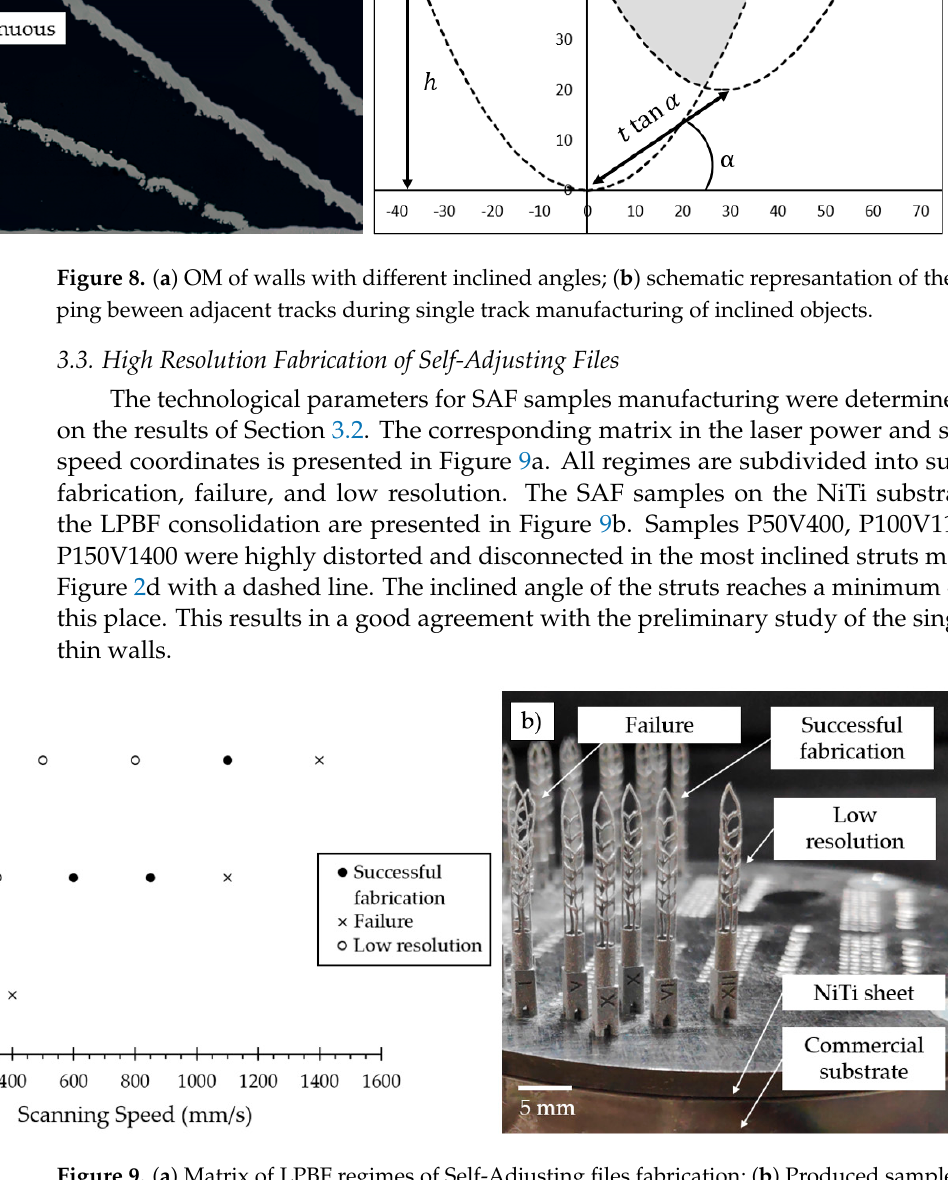
Figure 7. Dependence of wall thickness on linear energy density for inclined walls.